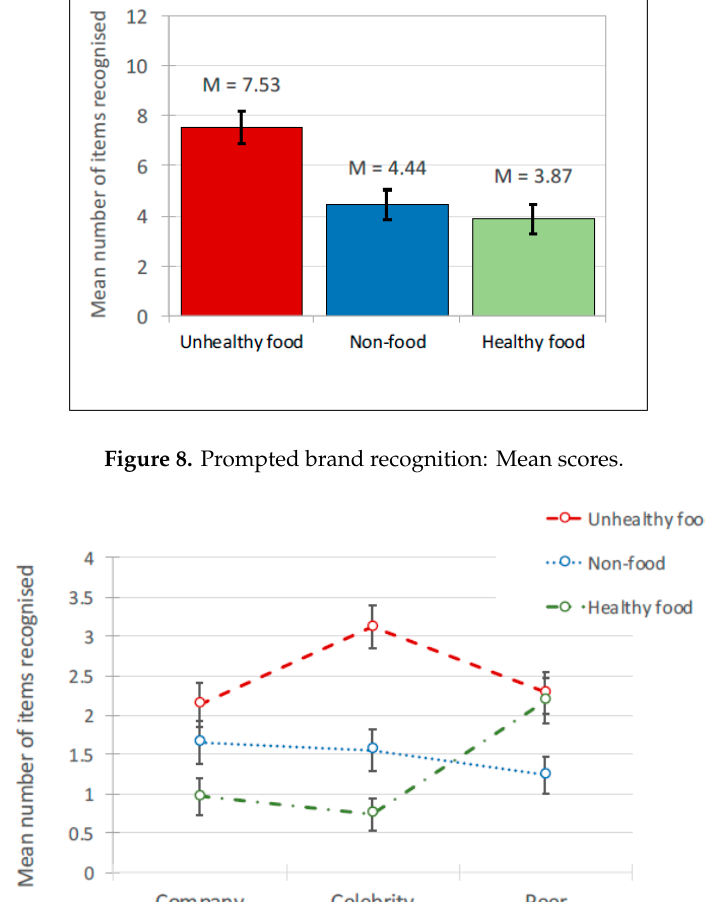
Table 6. Recall and recognition: Results of pairwise contrasts.